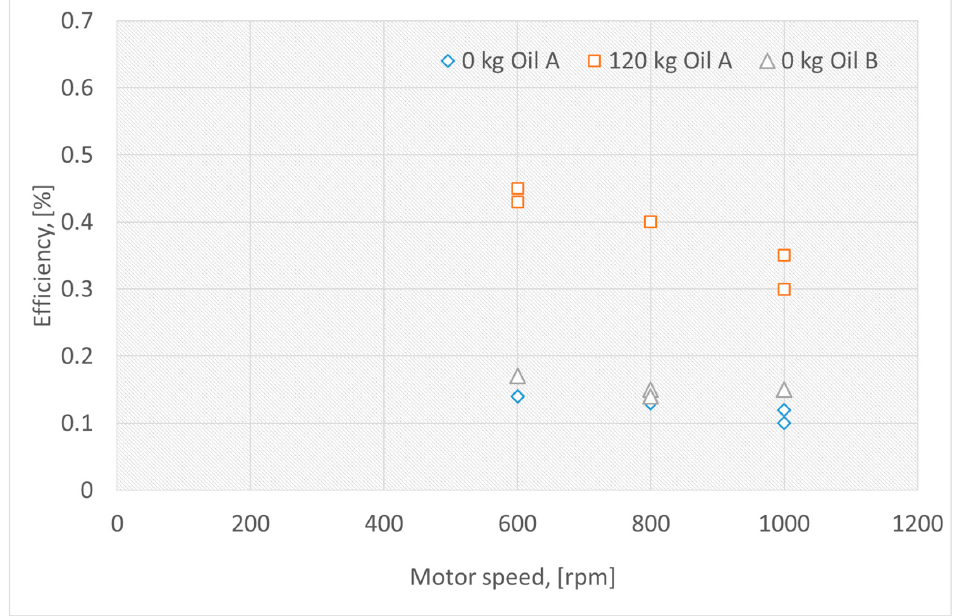
Figure 4. Measured data: DDH system total efficiency during lifting with various motor speed rpm and payload of 0 and 120 kg with oils A and B at ambient temperature +3 °C.